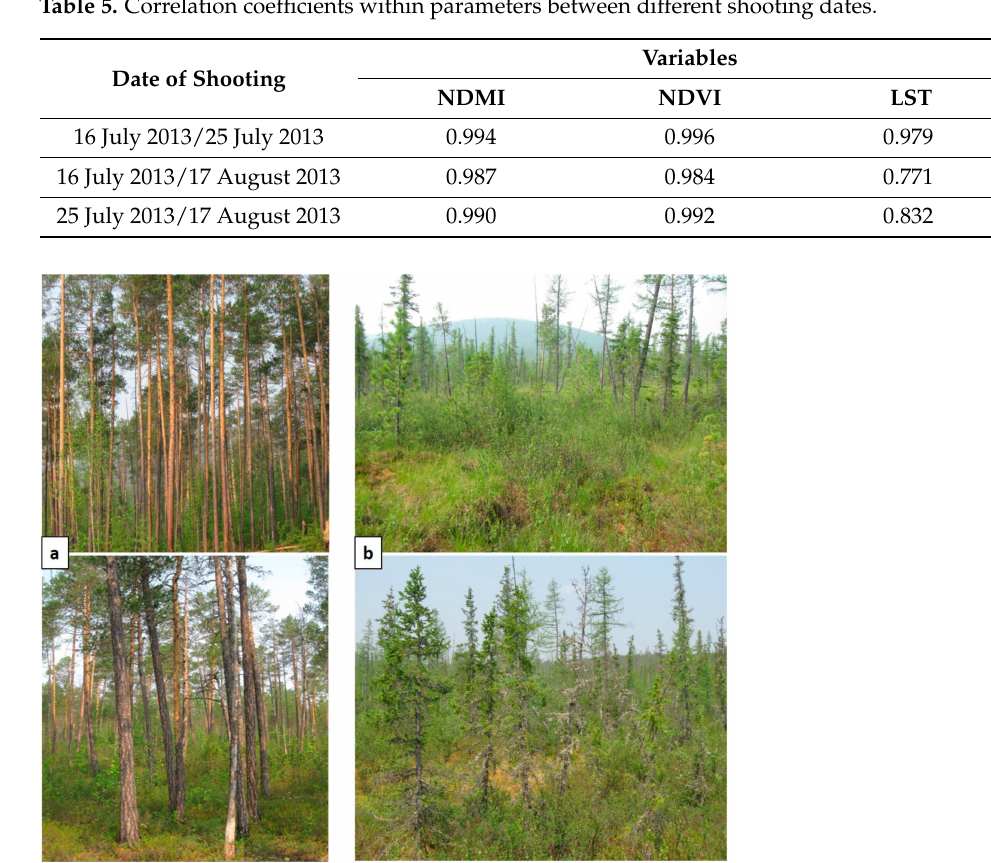
Figure 6. ( a ) Pine forest on dry permafrost. The trees are somewhat “drunken,” which is caused by solifluction in such geocryological conditions; ( b ) Typical permafrost landscape in the bottom of the valley: a “drunken” sparse stand with a predominance of Siberian cedar, Scots pine, and Siberian larch, and widespread growth of dwarf birch